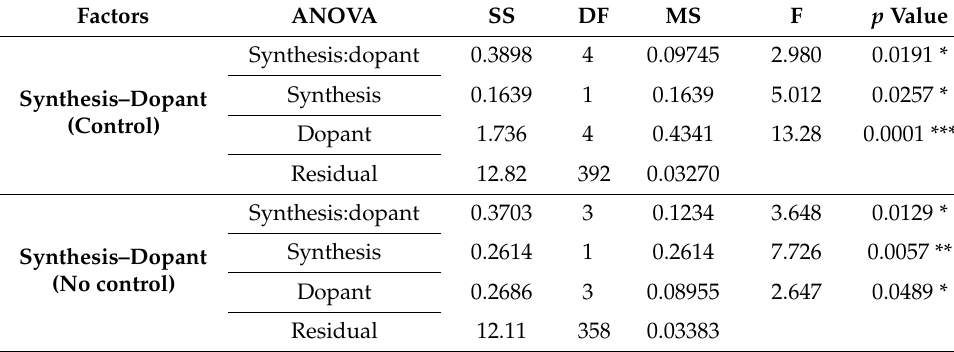
Table 6. Two-way ANOVA test for the first appearing stem